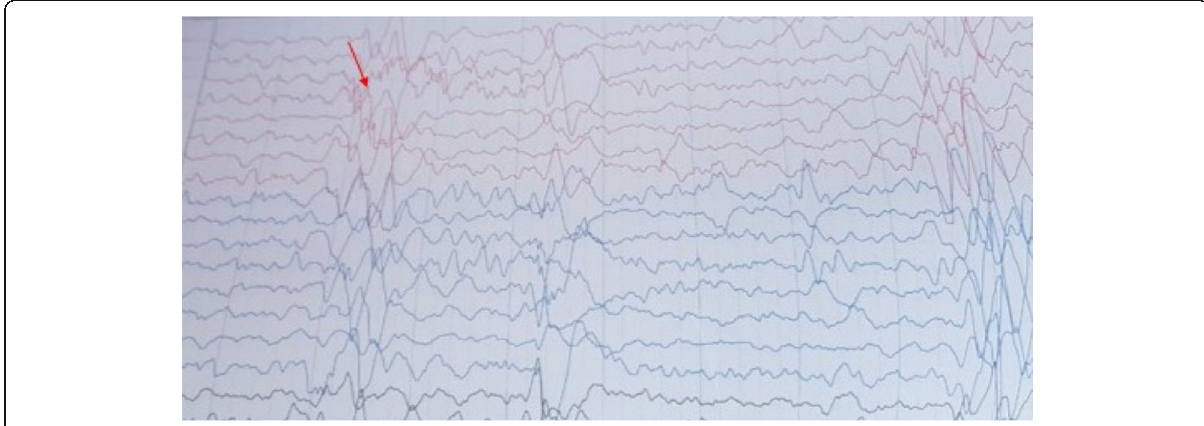
Fig. 6 EEG report examination revealed intermittent high voltage slow wave discharges (red